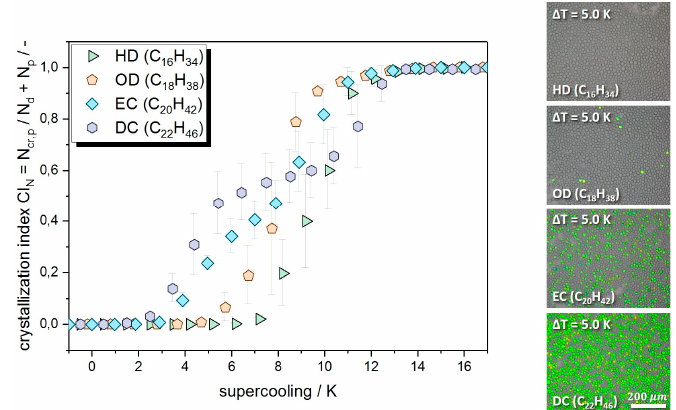
Figure 3. Number-based crystallization index CI N of 1 wt % alkane dispersions as a function of supercooling ∆ T with a cooling rate of 1 K/min. Length of the scale bar is 200 µ m.